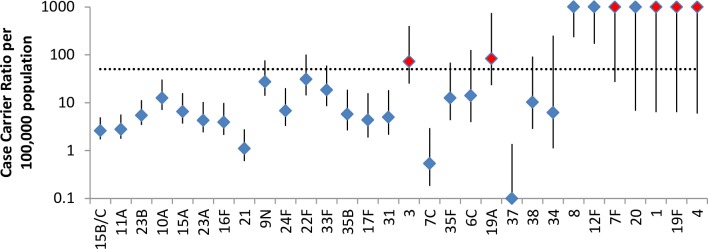
Case carrier ratios in 2015/16.The bar represents the 95% CI and vaccine serotypes are shown in red. Data includes just those aged <60 and serotypes with no carriage but at least 10 IPD isolates in 2015/16 in those aged <60 years.